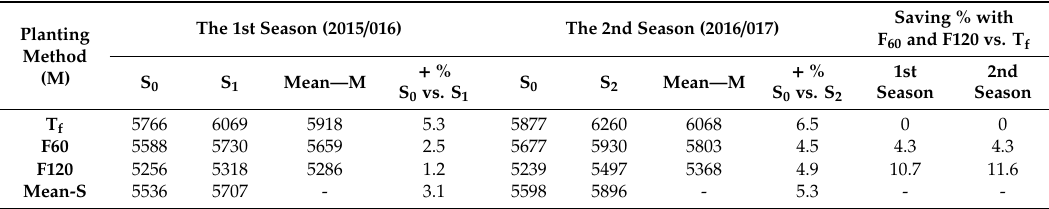
Table 6. Irrigation water applied (IWa—m 3 ha − 1 ) under di ff erent planting methods (M) and salinity conditions